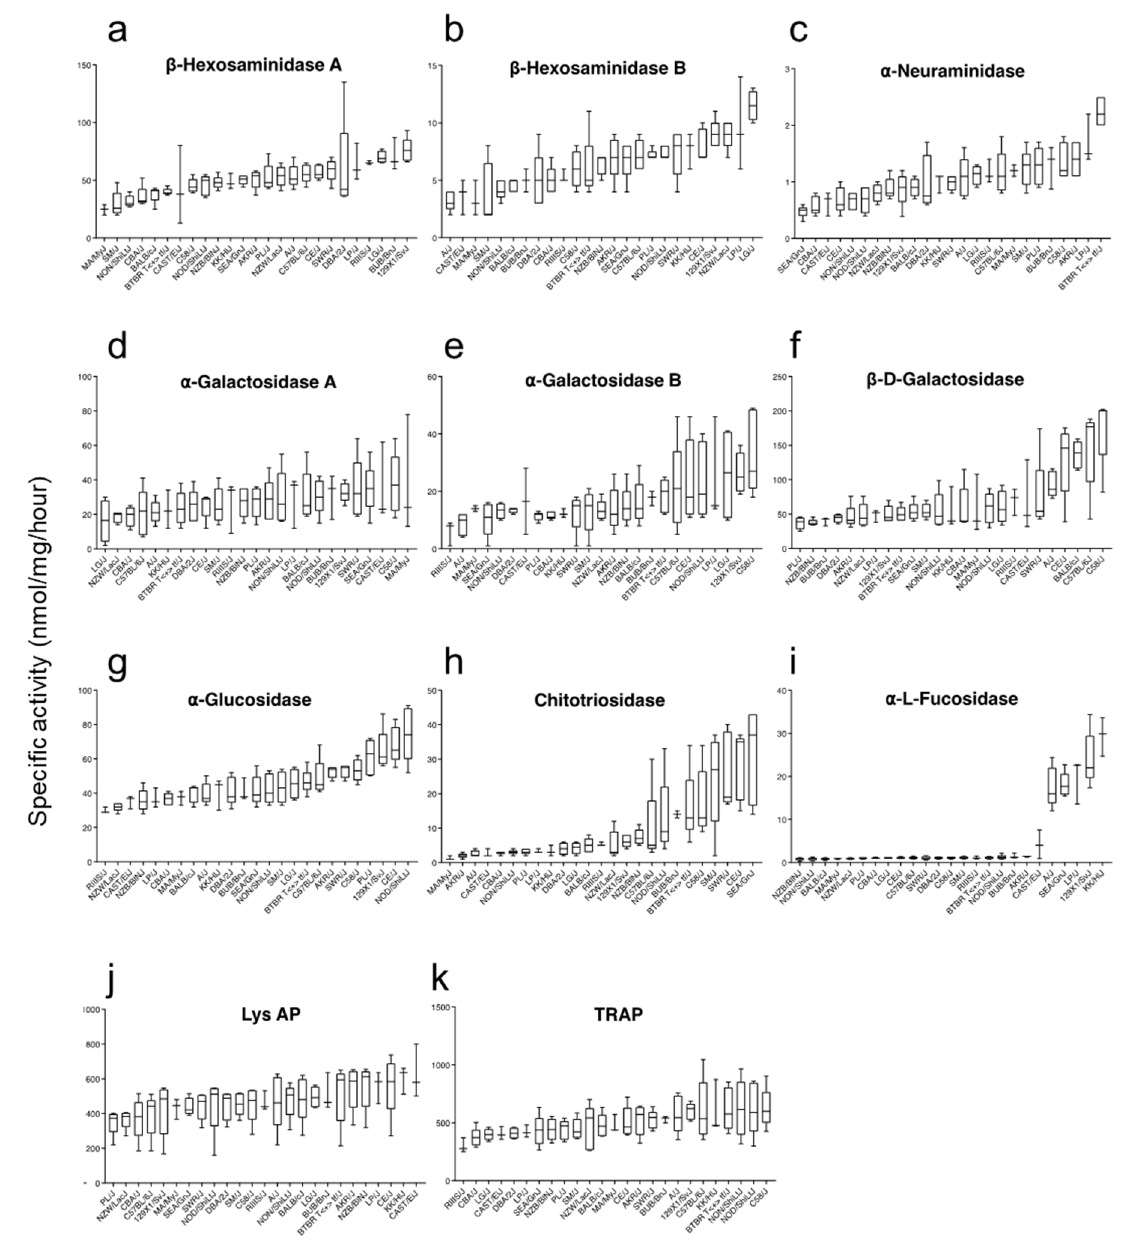
Figure 1. Hepatic variation in lysosomal enzyme activities across inbred strains. Enzyme activity are expressed as nmol/mg/hour. ( a ) Distribution of β -Hexosaminidase A. ( b ) β -Hexosaminidase B. ( c ) α -Neuraminidase. ( d ) α -galactosidase A. ( e ) α -galactosidase B. ( f ) β -D-galactosidase. ( g ) α -Glucosidase. ( h ) Chitotriosidase. ( i ) α -L-Fucosidase. ( j ) Lysosomal acid phosphatase. ( k ) Tartrate-resistant acid phosphatase, activity in the liver of 25 mouse inbred strains. Values are presented as median (n = 3–5 per strain).